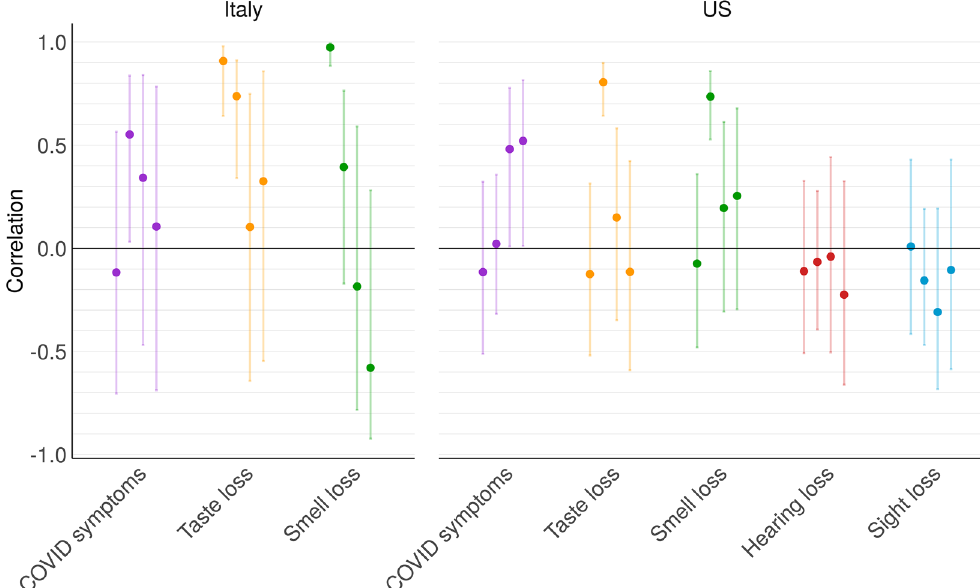
Figure 2. Correlation over geographical regions. For the weeks of 11–17 of March, 1–7 of April, 13–19 of May and 19–25 of August (in this order), correlations between the number of new COVID-19 cases (normalized with respect to 1,000,000 inhabitants) and popularity index of each search term are shown as round points. Confidence intervals (90%) calculated for each week separately are shown as error